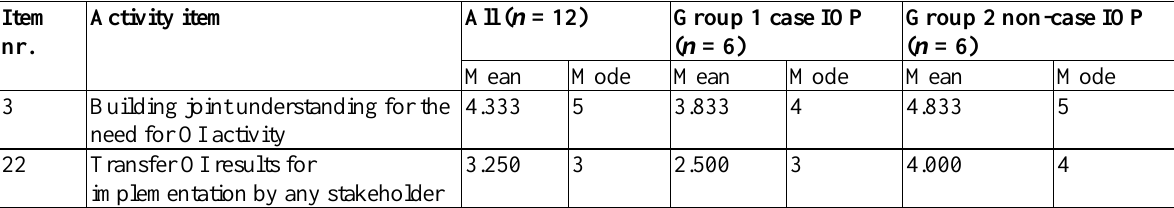
Table 4. Analysis of items with a significant difference in groups 1 and